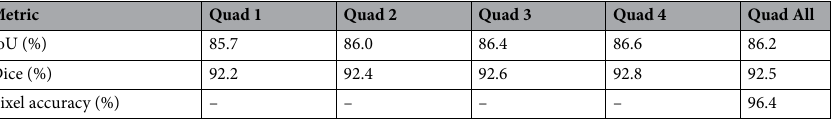
Table 2. Quadrant based segmentation metrics on the test dataset. Quad 1 indicates the first quadrant of every image. Quad All is the mean score of the all the quadrant